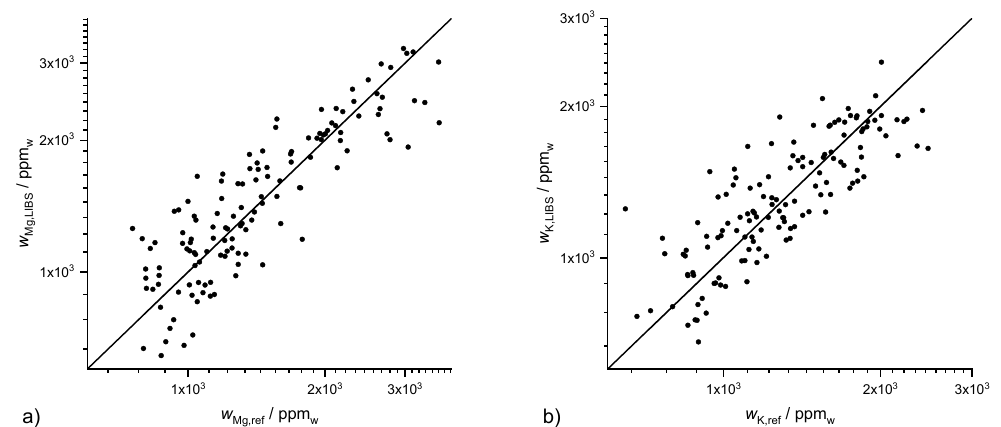
Figure 3. Results of 10-fold PLSR cross validation for ( a ) Mg with R 2 (Mg, PLSR) = 0.79, and ( b ) K with R 2 (K, PLSR) = 0.64.